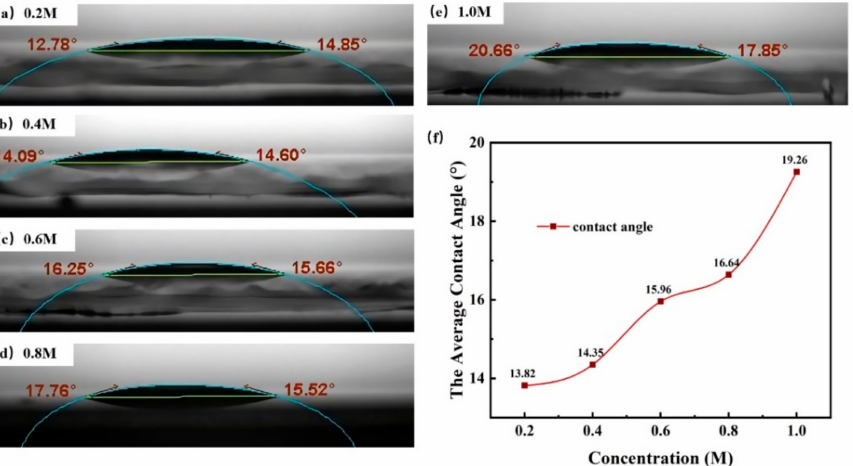
Figure 2. Surface contact angle of different concentrations solutions: ( a ) 0.2 M, ( b ) 0.4 M, ( c ) 0.6 M, ( d ) 0.8 M, ( e ), and 1.0 M. ( f ) Relationship between concentrations and the average contact